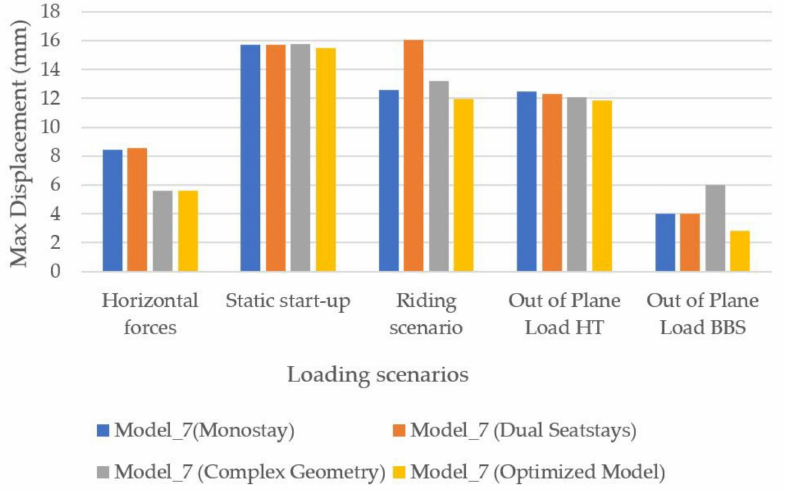
Figure 18. Maximum displacement per model in horizontal impact, static startup, riding, out-of-plane load in the headtube, and out-of-plane load in the bottom bracket shell scenarios.